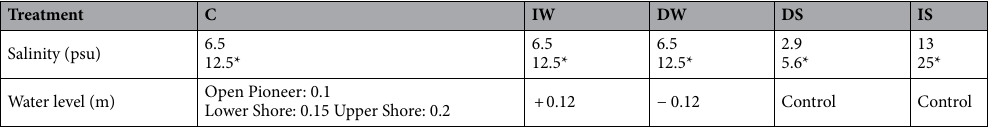
Table 2. Treatments in the mesocosm experiment. Salinity is given as practical salinity unit (psu) and water level in relation to the soil surface (m). Water level below control level is denoted with minus and water level above control level is denoted with plus sign. C control, IW increased water level, DW decreased water level, DS decreased salinity, IS increased salinity. (*) Refers to Open Pioneer